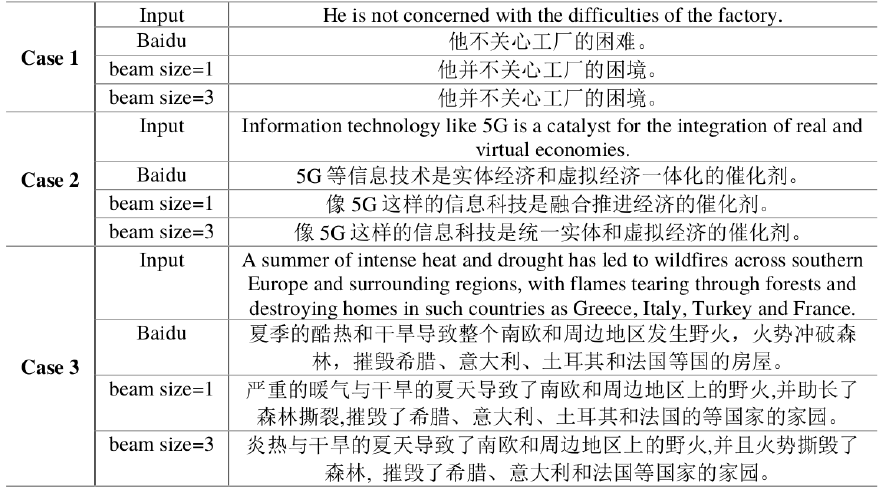
Figure 11. The translation cases of using Baidu translation system and our